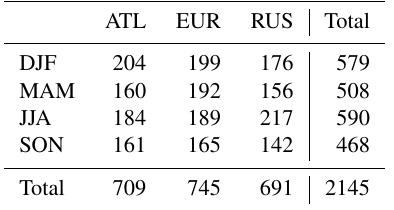
Table 2. As Table 1 but for